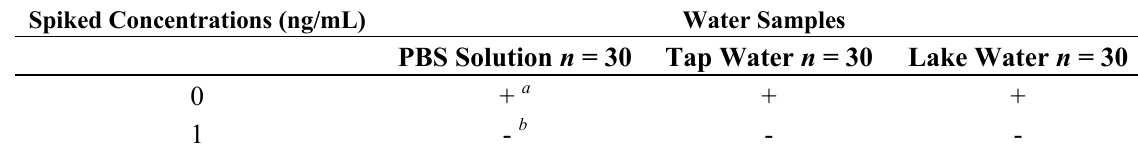
Table 4. Performance Strip